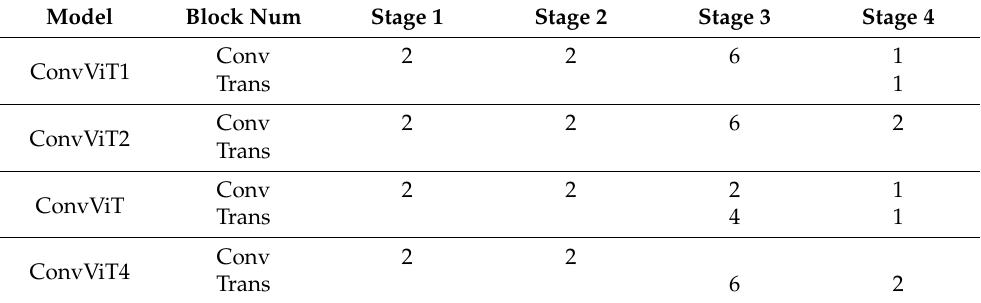
Table 4. The parameters setting of ConvViT level model, “Conv” indicates Convolution Structure, “Trans” indicates Transformer Structure.